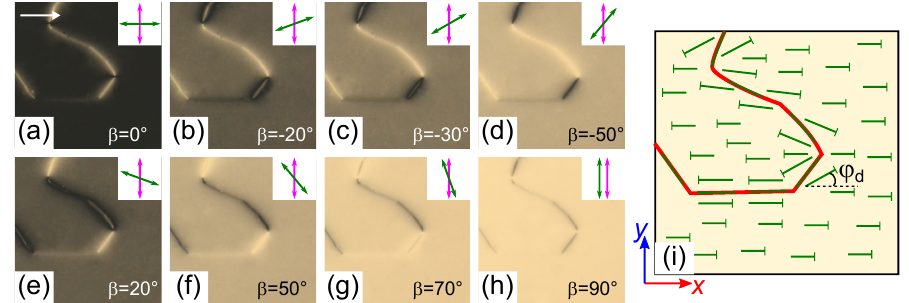
Figure 3. POM photos of sample area presented in Figure 2. The polarizer is perpendicular to the rubbing direction of PVA film. The β angle between the analyzer and rubbing direction is 0 ◦ ( a ), − 20 ◦ ( b ), − 30 ◦ ( c ), − 50 ◦ ( d ), 20 ◦ ( e ), 50 ◦ ( f ), 70 ◦ ( g ), 90 ◦ ( h ). Corresponding scheme of director orientation at the top substrate covered with PiBMA ( i ). The POM photos show 380 × 380 µ m area. The domain wall is indicated by the red line. The angle ϕ d is an azimuthal angle of director at the top substrate.